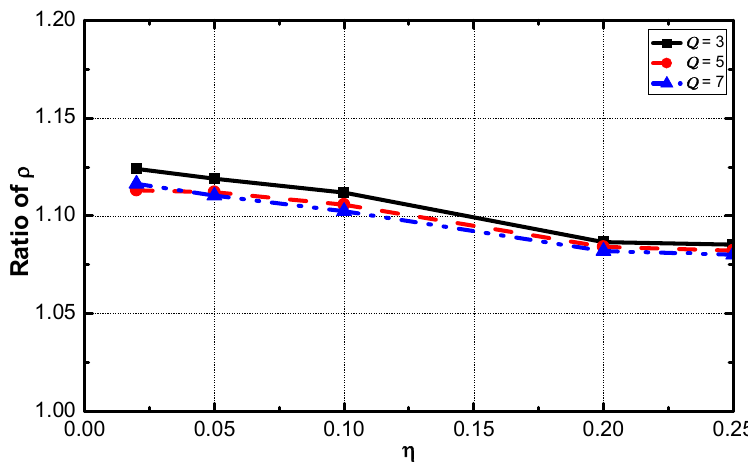
Figure 17. The ratio of service guarantee rate vs. η .